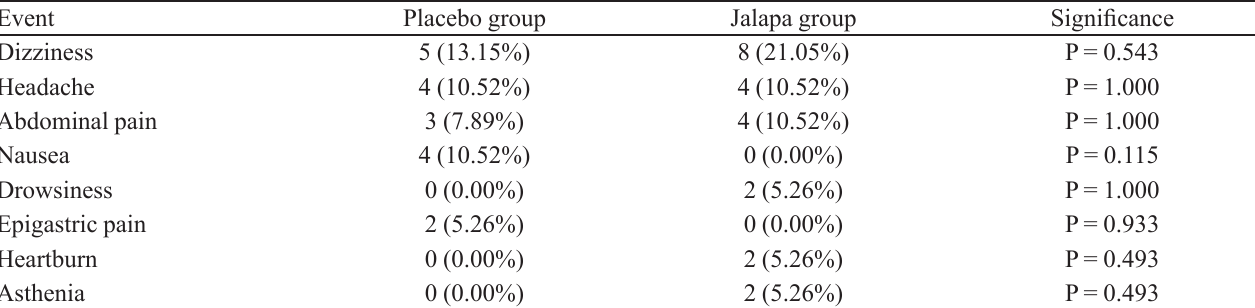
TABLE III - Adverse events reported by the patients in the jalapa and placebo groups Event Placebo group Jalapa group